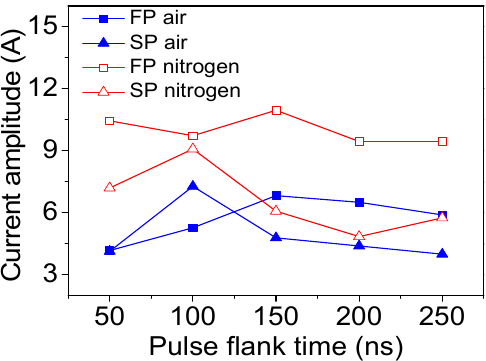
Figure 4. Waveforms of the applied voltages and discharge currents under different pulse rising and falling times.